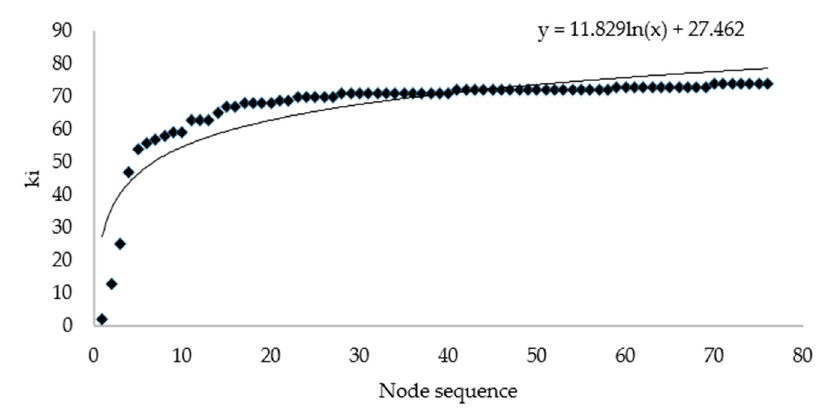
Figure 3. Degree distribution of major nodes.